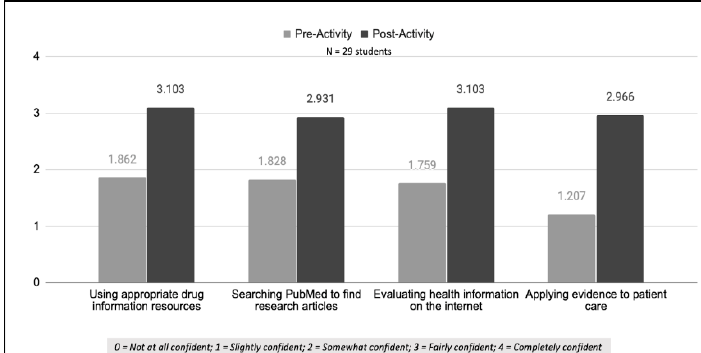
Figure 1 IPPE Drug Information Self-Efficacy Survey